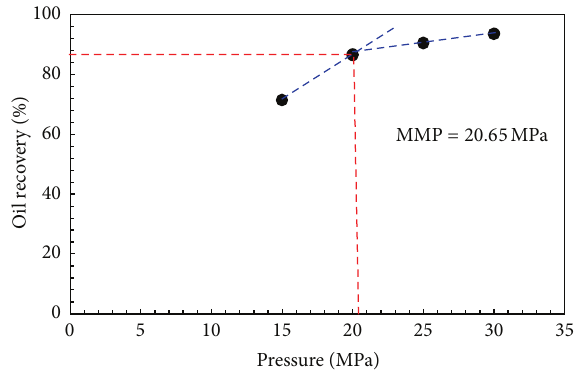
Figure 2: Variation of the oil recovery measured at 1.20 pore volume of CO 2 injected at various injection pressure for oil sample 1.